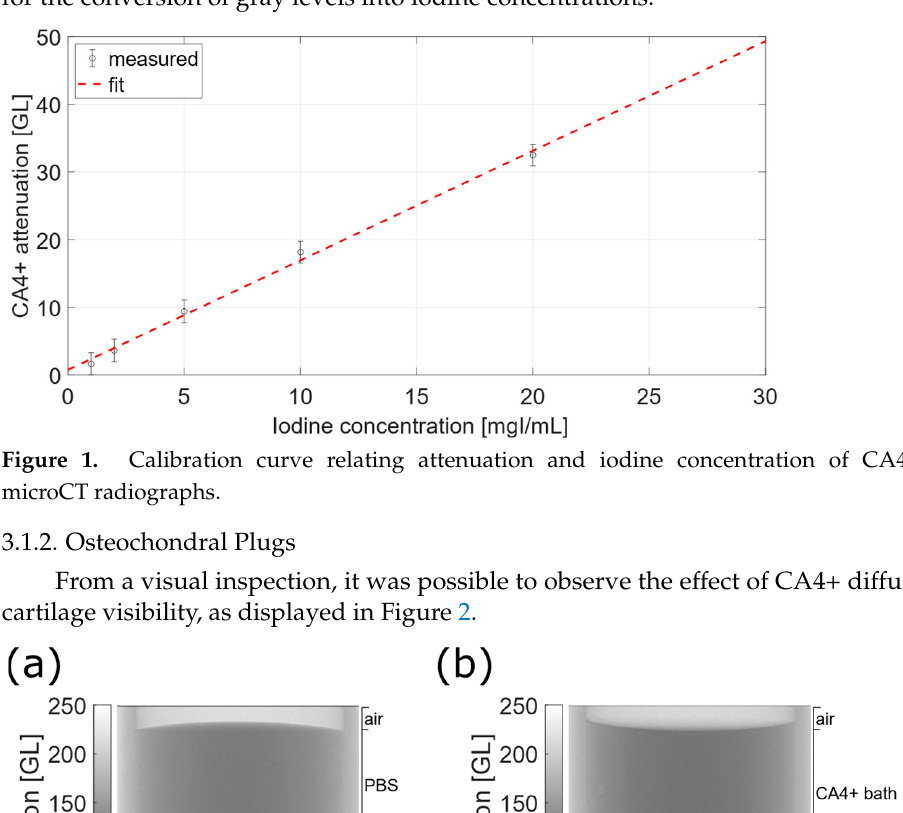
Figure 3. Mean attenuation profiles reported as a function of cartilage depth for femoral ( a ) and tibial ( b ) samples. Each attenuation profile refers to a specific diffusion time, as pointed out by the legend. Cartilage depth is drawn from cartilage surface (namely 0) to cartilage tidemark (namely the cartilage-subchondral bone interface, 1). The saturation times, namely, the time required for the cartilage to reach 95% of bath attenuation, were τ F95 = 1.9 ± 0.9 h and τ T95 = 2.6 ± 2.0 h for femoral and tibial samples, respectively. The iodine concentration reached in the cartilage was computed using the calibration curve previously obtained. Such conversion was carried out after baseline images were subtracted to each time point acquisition after CA4+ immersion, in order to exclude any attenuation attributable to water and PMMA. The diffusion curves, obtained by collecting the average values of attenuation and iodine concentration as a function of time, are reported in Figure 4.